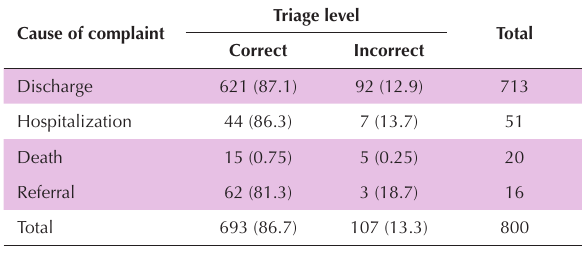
Table 4. Relationship between triage and outcome